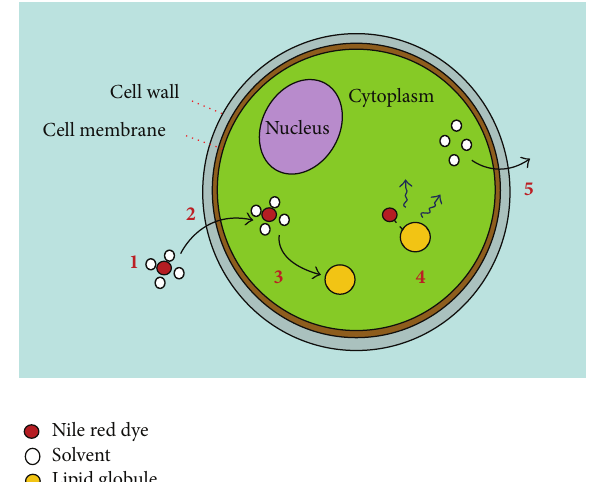
Figure 7: A schematic diagram showing the pathway that drives Nile red interaction with microalgal intracellular lipid. Stage 1: dissolution of Nile red dye in the carrier solvent; Stage 2: diffusion of the dye-solvent complex across the cell wall and the cell membrane into the cell; Stage 3: transfer of the dye to the lipid globule; Stage 4: interactionofthedyewiththelipidglobuleresultinginfluorescence; and Stage 5: diffusion of the carrier solvent out of the